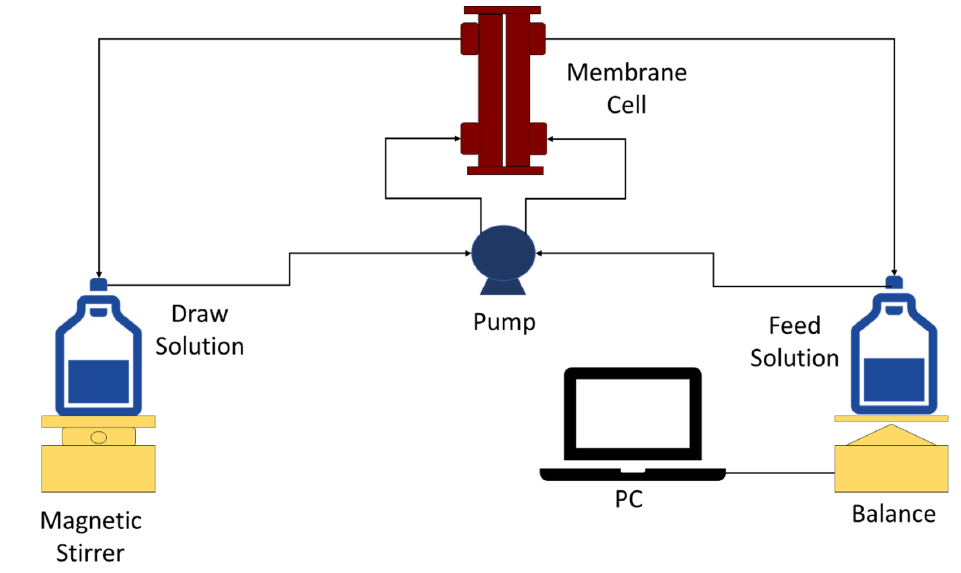
Figure 1. Schematic diagram of FO system.